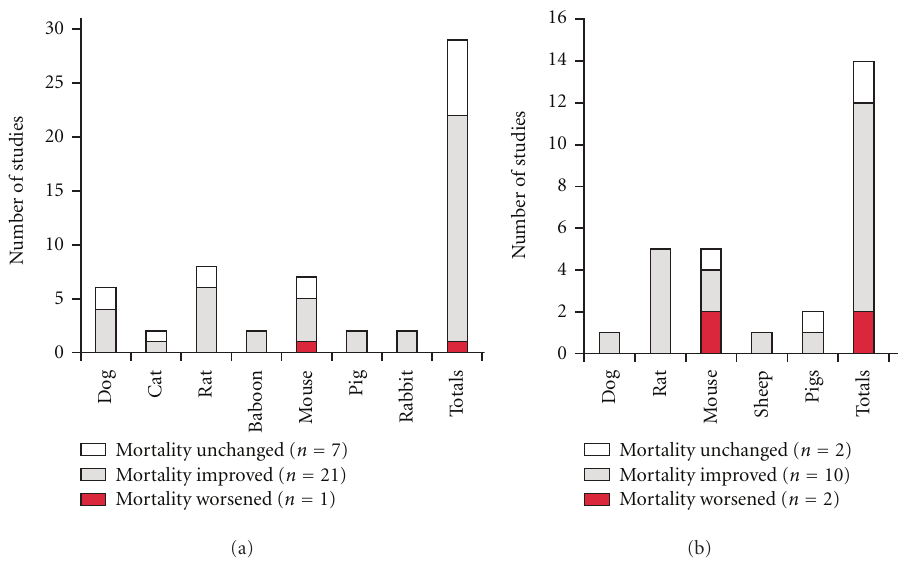
Figure 1: Influence of COX inhibitors on animal models of sepsis. (a) Studies were reviewed for experiments in which mortality was assessed for animals treated with COX inhibitors either before or after the systemic administration of pathogen-associated molecular patterns (generally, lipopolysaccharide). One mouse study (that showed a benefit to survival) included COX-2 knockout animals and not a pharmacological inhibitor. (b) Studies were reviewed for experiments in which mortality was assessed for animals treated with COX inhibitors either before or after the induction of systemic infection (see text for details). One mouse study (that showed a reduction in survival) included COX-2 knockout animals and not a pharmacological